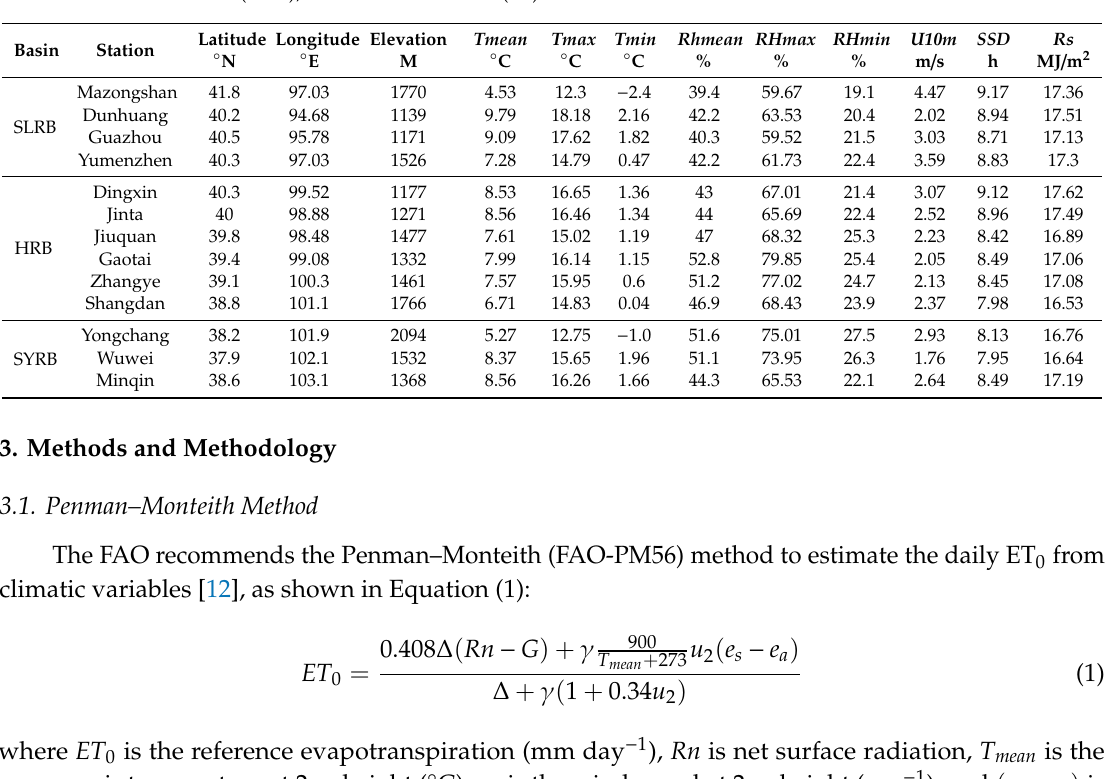
Table 1. Properties of thirteen meteorological stations with long-term average climatic conditions. minimum, mean, andmaximumairtemperature( T min , T mean , and T max ), mean, maximum, andminimum relative humidity ( Rhmean , Rhmax and RHmin ), wind speed measured at 10 m height ( U 1 0 m ), sunshine duration ( SSD ), and solar radiation ( Rs